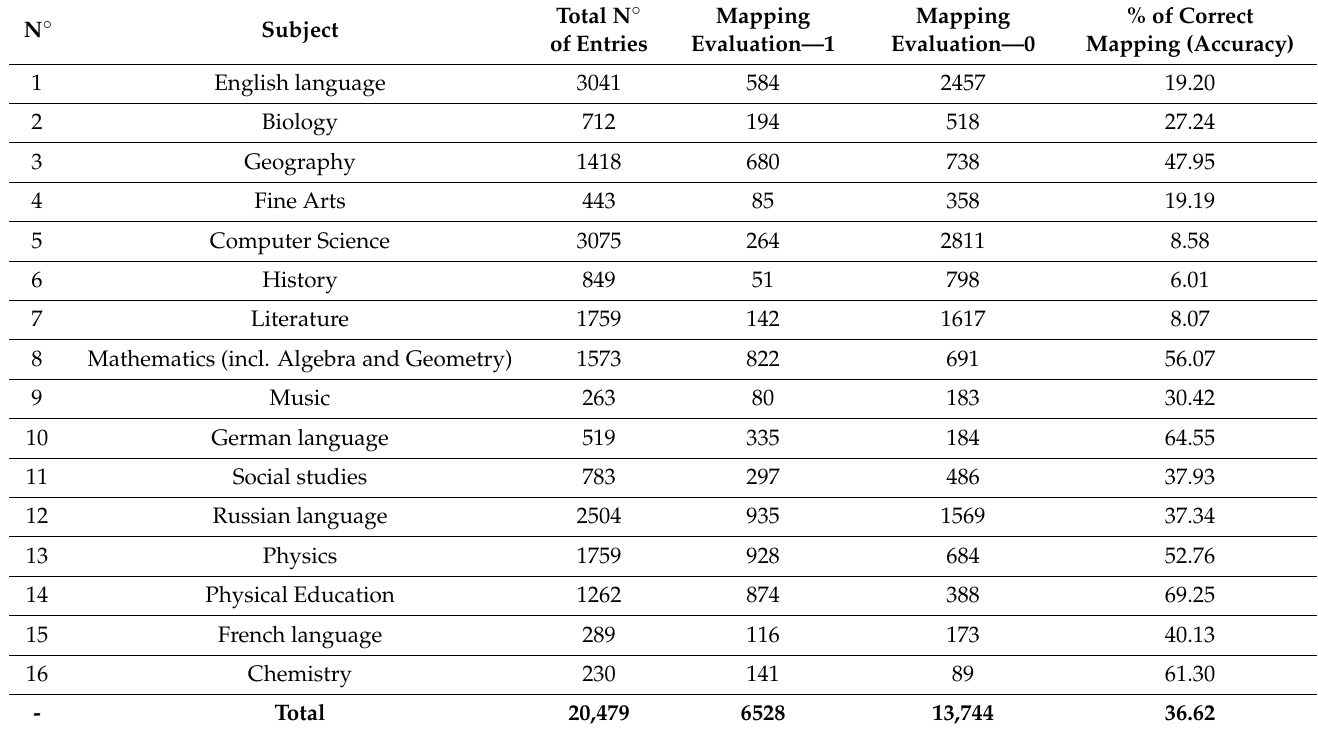
Table 4. Results of expert evaluation of the semantic algorithm